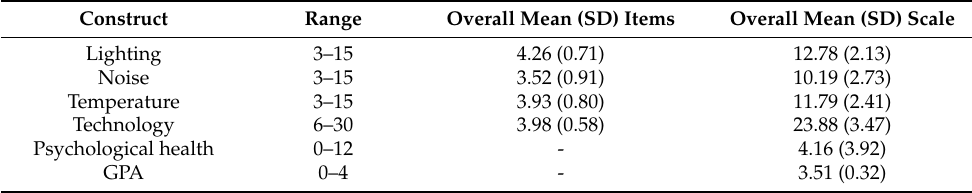
Table 2. The descriptive statistics of constructs (n = 207).